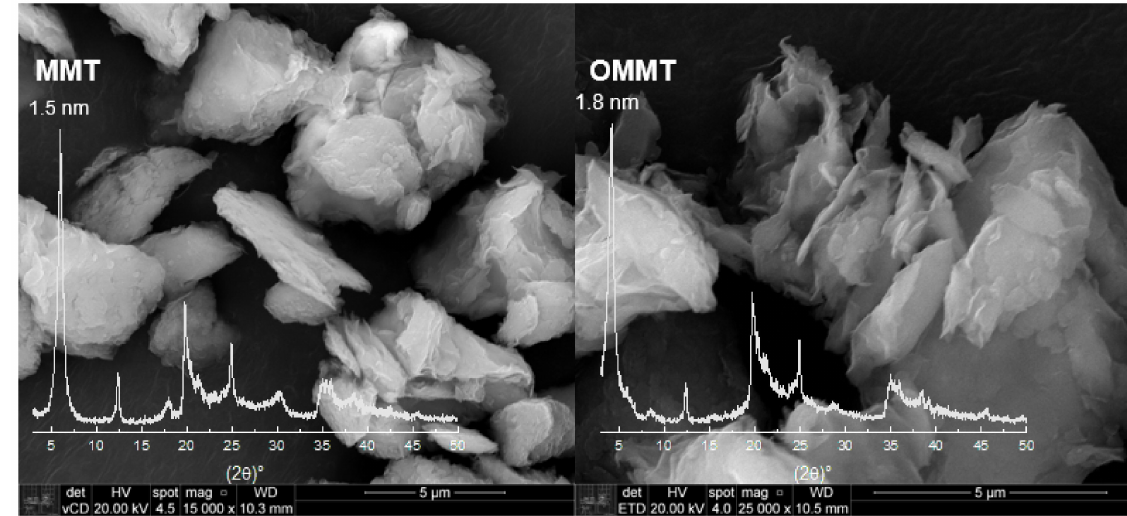
Figure 1. XDR and scanning electron microscopy of montmorillonite (MMT) and organophilized montmorillonite (OMMT) samples (bar indicates 5 µ